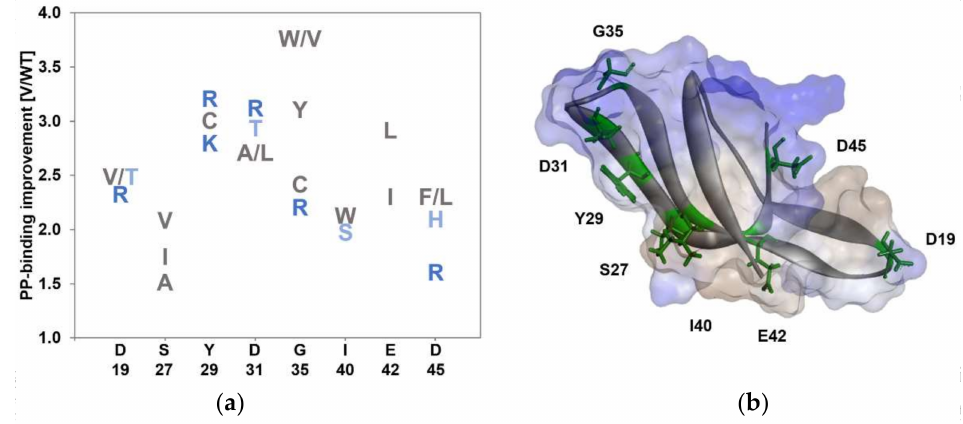
Figure 2. Amino acid substitutions at LCI key positions for stronger PP-binding: ( a ) Beneficial amino acid substitutions for selection with non-ionic surfactant Triton X-100 (identified by site-saturation mutagenesis). Positions with substitutions that led to variants with a variant–wild type (V/WT) ratio ≥ 1.5 were considered as beneficial key positions. Amino acids are colored according to their chemical properties (positively charged: K, and R (dark blue); polar: H, S, T, N, and Q (light blue); hydrophobic: F, Y, W, A, V, L, I, and C (grey); ( b ) Model of LCI wild type generated with the Discovery Studio 4.0 Client. Identified beneficial positions (D19, S27, Y29, D31, G35, I40, E42, and D45) are highlighted in green. Blue indicates hydrophilic surface areas, and grey scales indicate hydrophobic surface areas. The model is based on PDB entry 2B9K conformer 3